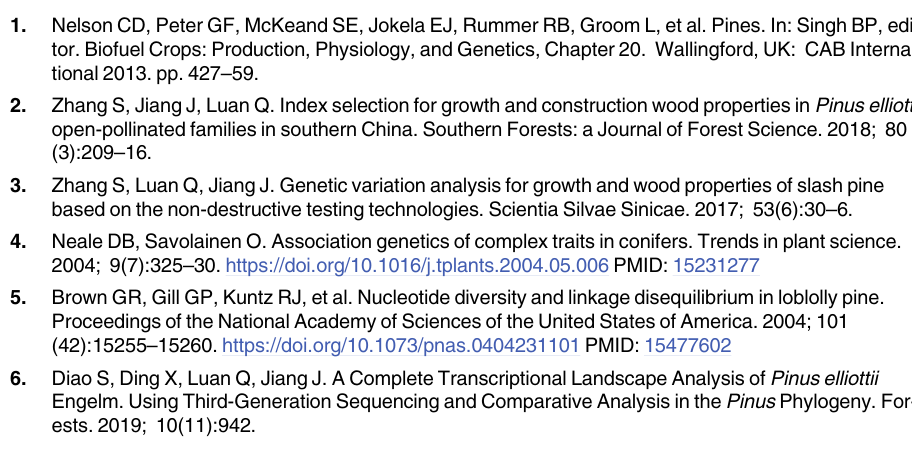
S10 Data. Source data for Fig 9. qRT-PCR validation of candidate genes associated with oleo- resin yield and growth